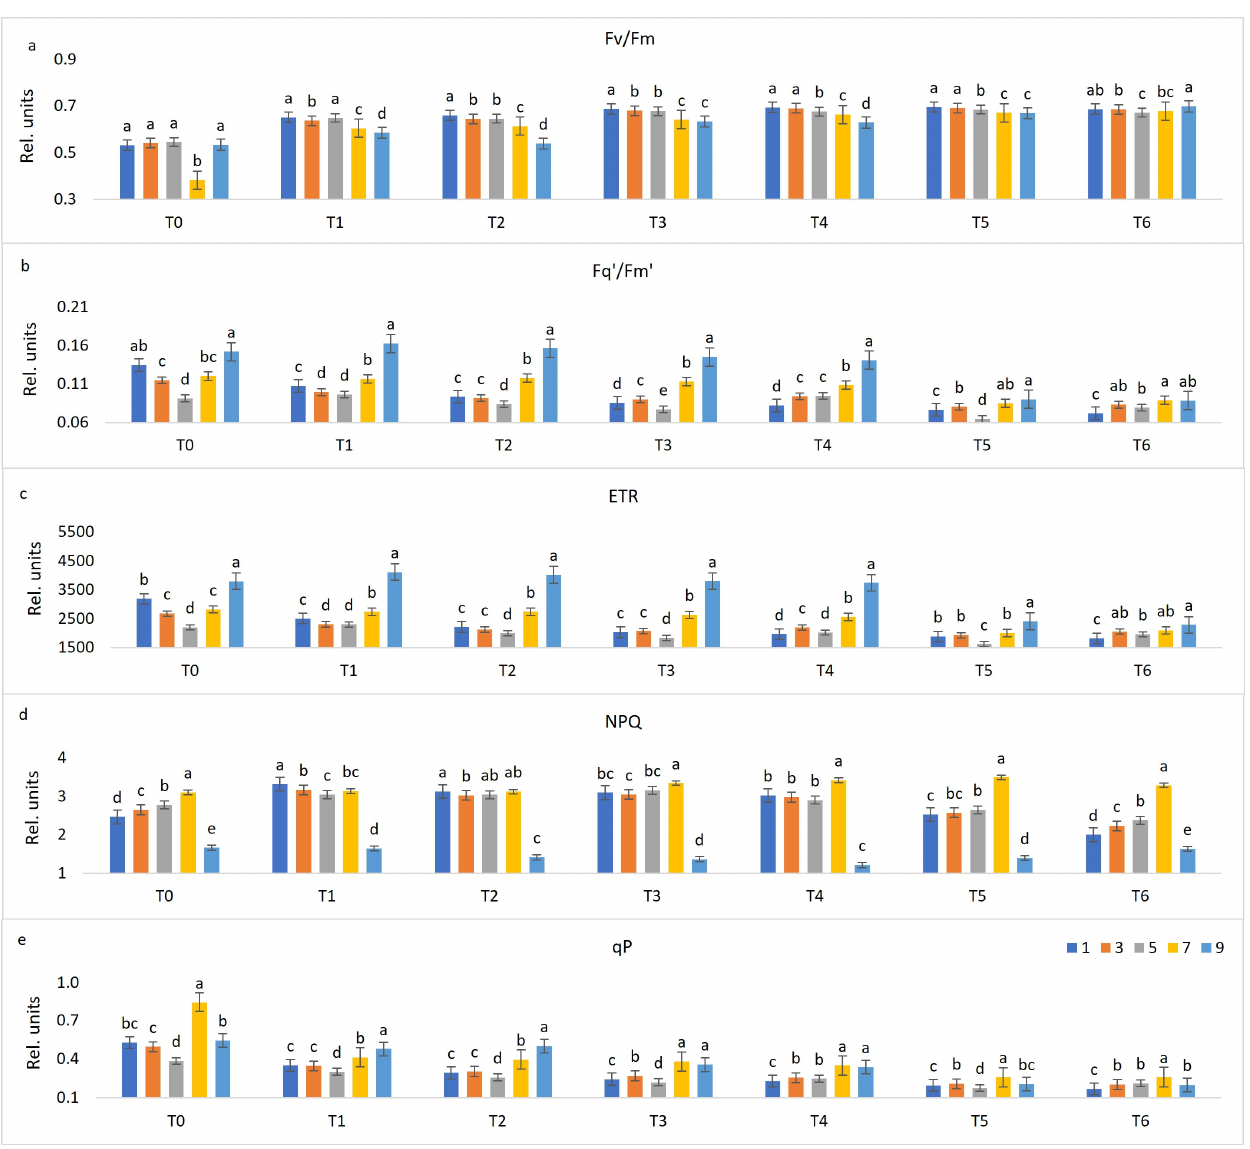
Figure 4. Changes between distinctive OIV classes (1 – most susceptible; 9 – resistant) throughout seven terms (before treatment (T 0 ), one day post-inoculation (dpi) (T 1 ), two dpi (T 2 ), three dpi (T 3 ), four dpi (T 4 ), six dpi (T 5 ) and eight dpi (T 6 )) in chlorophyll fluorescence parameters. Differences between the means were evaluated by Duncan’s multiple range test at a confidence level of 95% ( p < 0.05). Means with the same letter are not significantly different. Sub-figures depict parameters as follows: ( a ) F v /F m , ( b ) F q’ /F m’ , ( c ) ETR, ( d ) NPQ, and ( e )